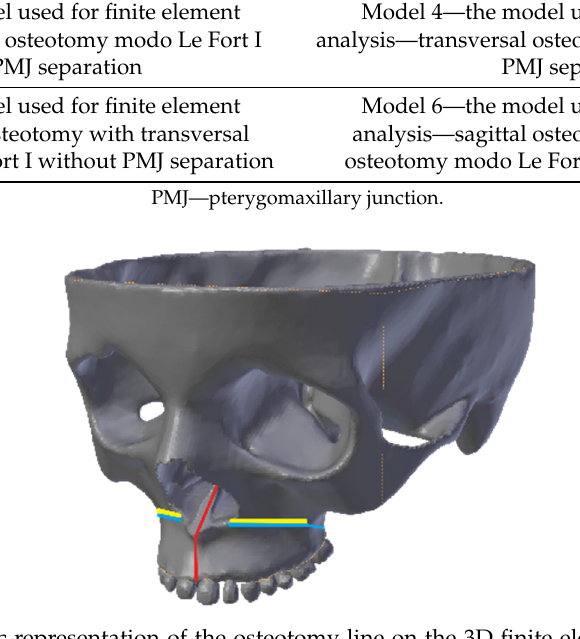
Figure 4. Schematic representation of the osteotomy line on the 3D finite element model of facial skeleton. Red color marked-sagittal osteotomy; yellow color marked-transversal osteotomy modo Le Fort I without pterygomaxillary junction separation; blue color marked—transversal osteotomy modo Le Fort I with pterygomaxillary junction separation.